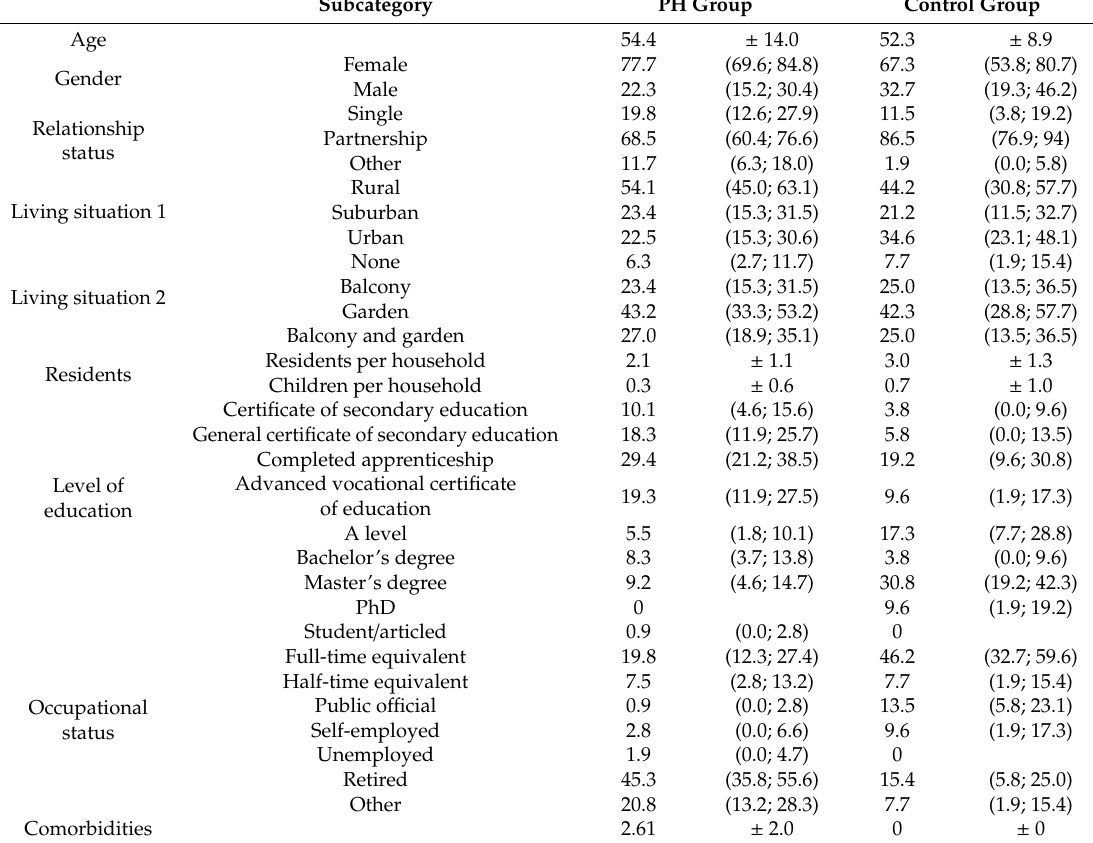
Table 1. Sociodemographic characteristics of patients with pulmonary hypertension (PH group) and subjects of the control